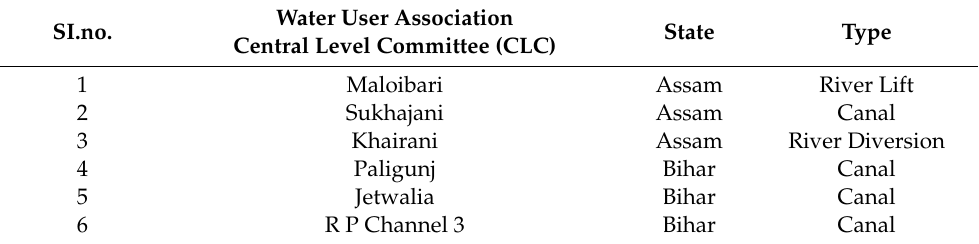
Table 2. Case studies of water user associations in the Eastern Indo-Gangetic plains.